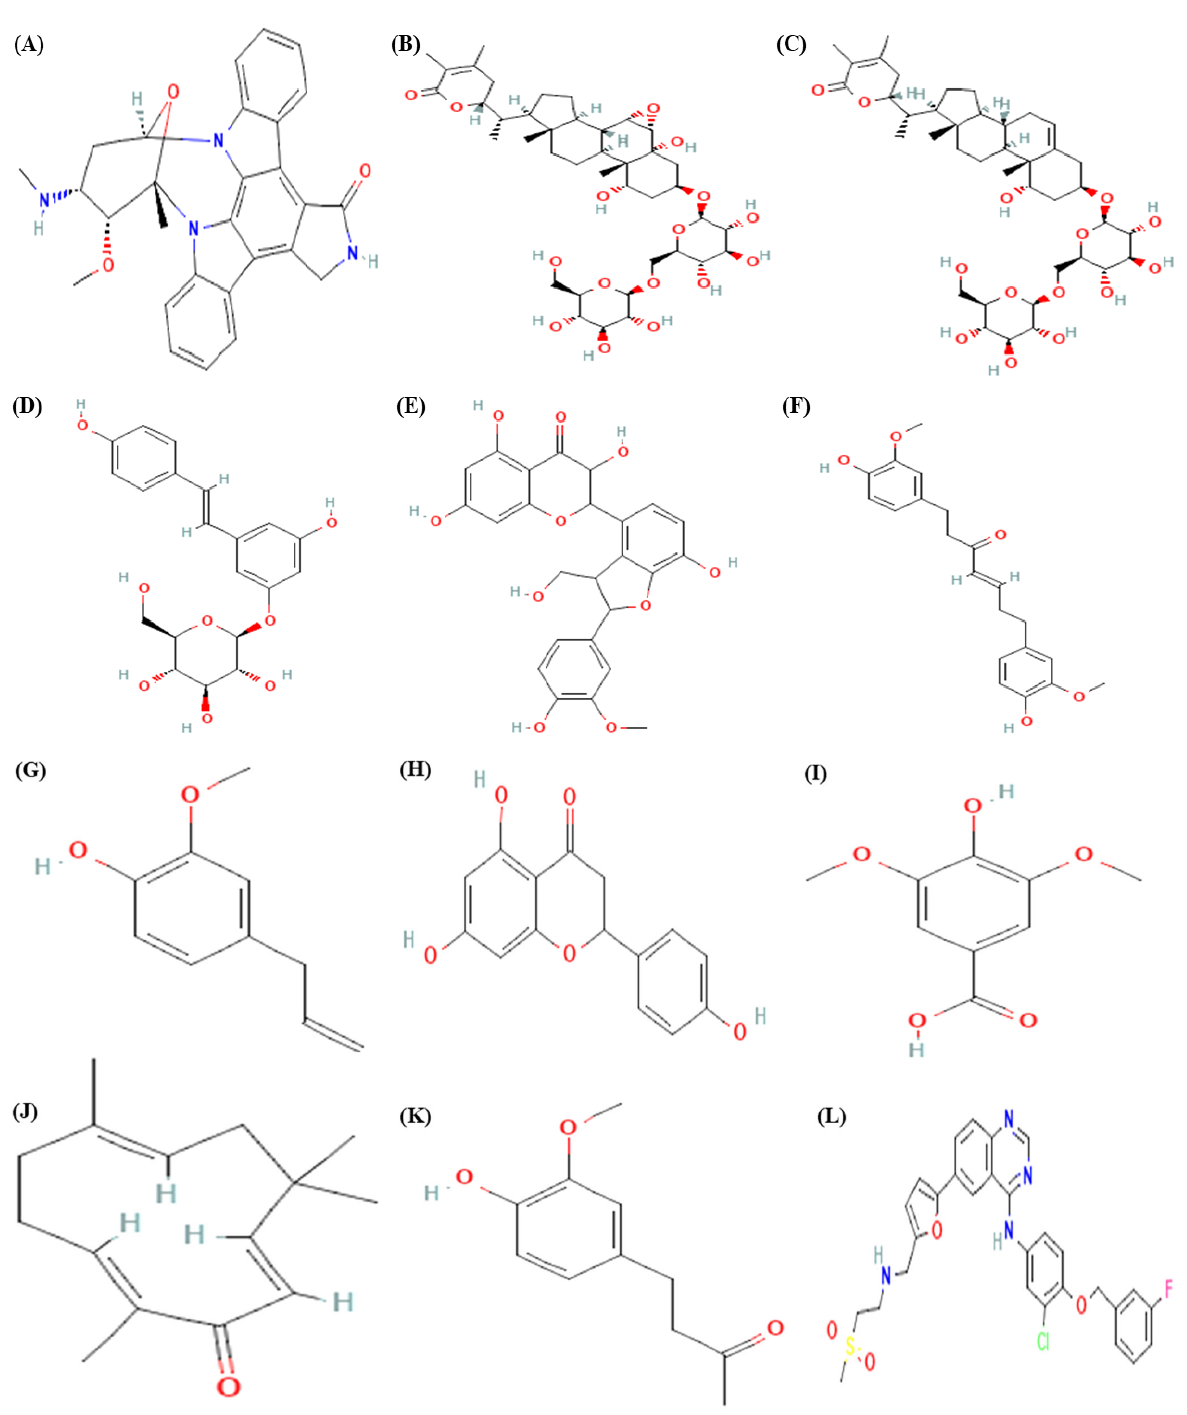
The 2D interaction of G6PD protein with four best docked compounds and a standard drug (Lapatinib) is graphically shown in Figure 2.